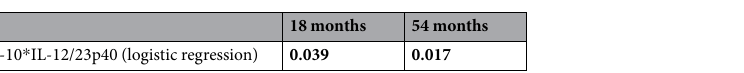
Table 9. Logistic regression analysis for IL-10 and IL-12/23p40 in PiB + and PiB − HC.